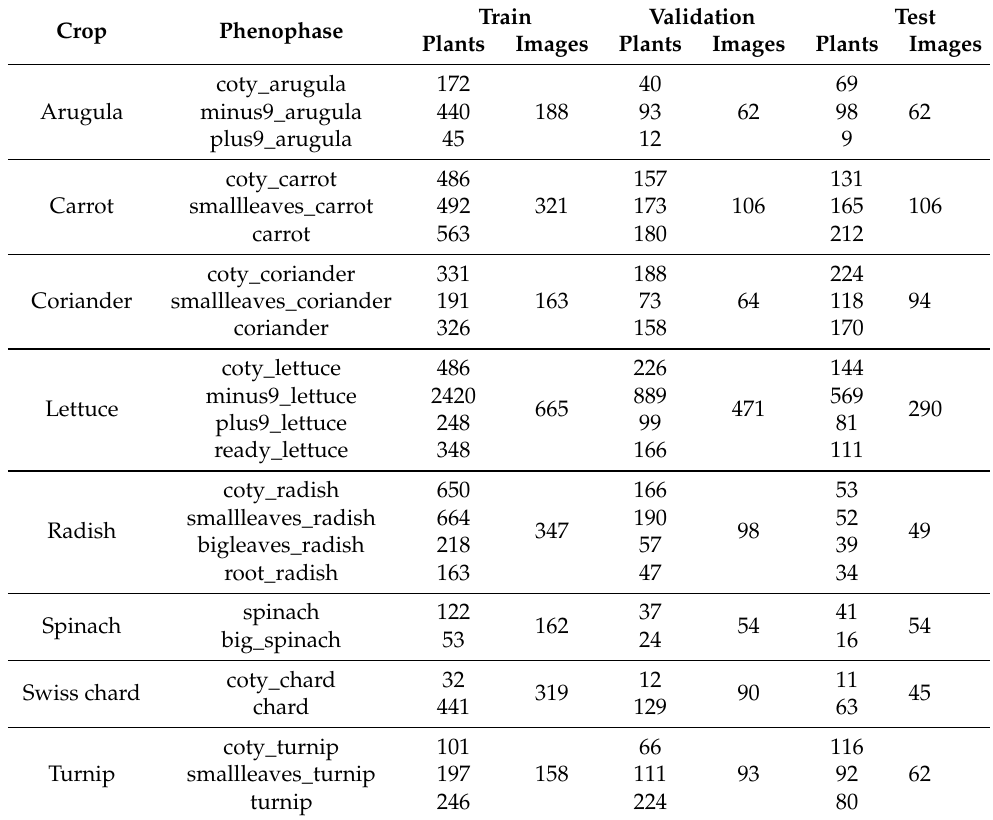
Table 3. Dataset split of each crop and phenophase images and plants for the training and evaluation of deep learning models (considering only RGB images).